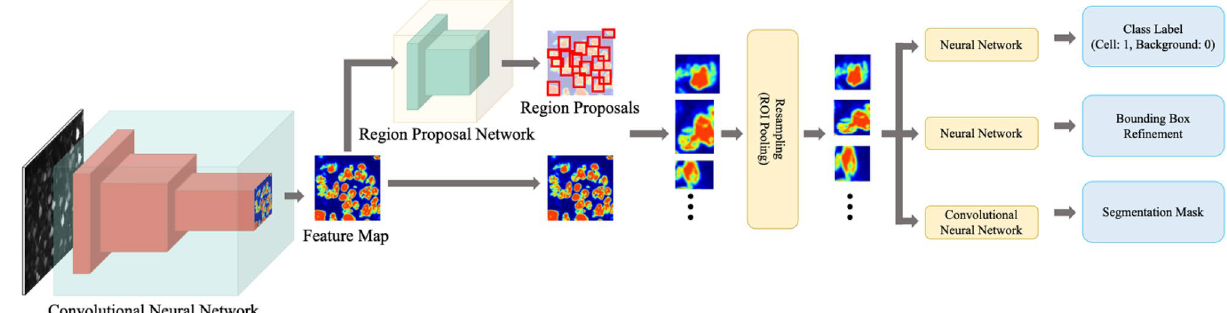
Figure 6. Mask R-CNN architecture. The architecture took a cell image as an input, which was then processed by a convolutional neural network to generate feature maps. Each pixel of the feature maps represented an artificial neuron’s activation covering a localized receptive field at the corresponding spatial location. The feature maps were then passed to the region proposal network (RPN), which processed candidate regions (red boxes) where soma might exist. This made the search process more efficient compared to an exhaustive search. The region proposals were then resampled to square-shaped image patches to make them compatible with the later processes. After resampling, three different artificial neural networks were applied to square patches: one for determining whether the region proposal contains a soma or not; another for refining the bounding boxes to fit the soma more tightly; and the other for generating segmentation masks of